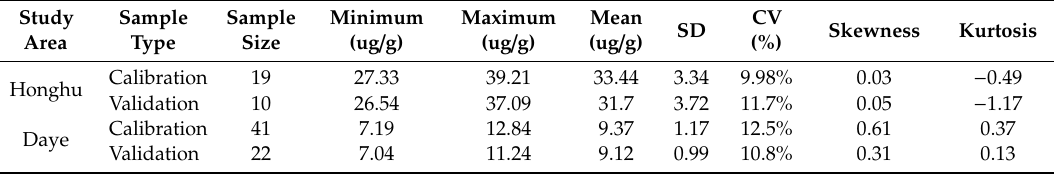
Table 1. Statistical characteristics of the soil As content.